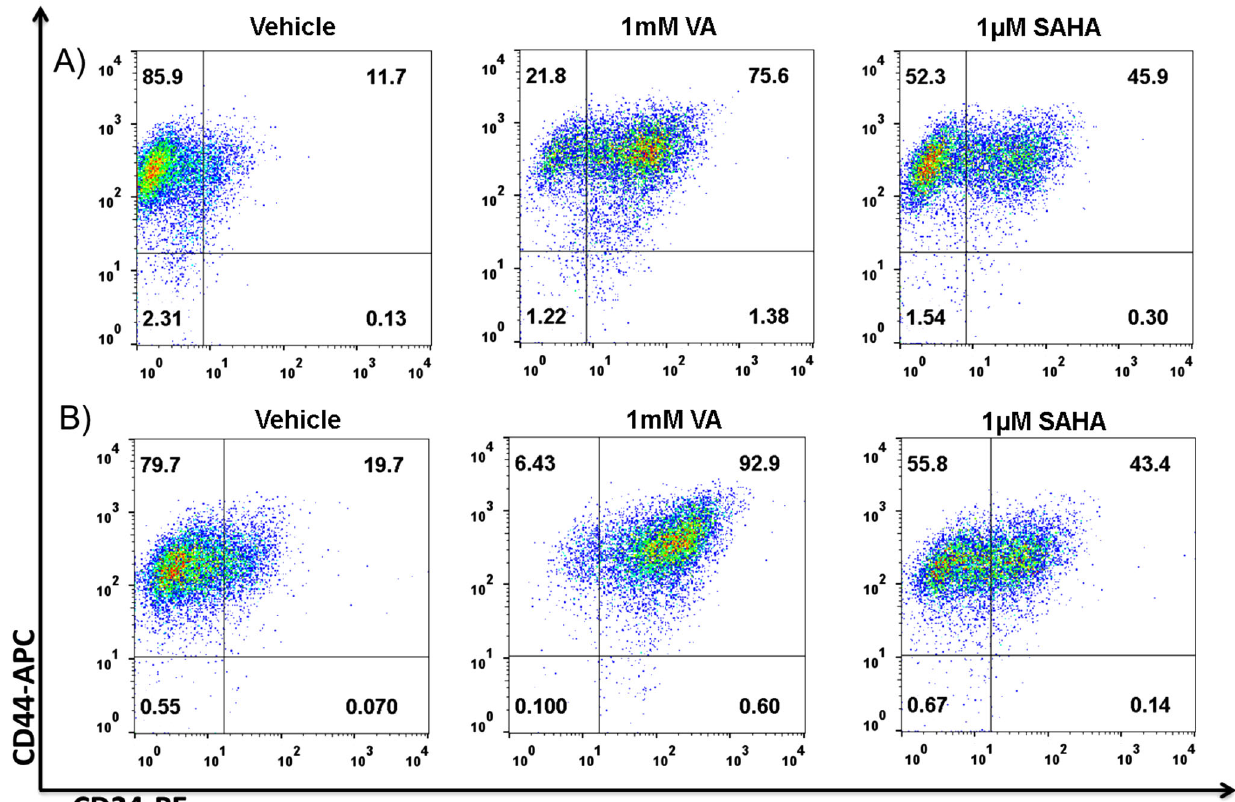
Fig. 4 HDAC inhibitors expand the CD44 + /CD24 + subpopulation. Flow cytometry analysis of expression of CD24 and CD44 in a ALDH − and b ALDH + SUM159 cells showing a shift from the CD44 + /CD24 − in the vehicle-treated to a CD44 + /CD24 + population in 1 mM VA or 1 µM SAHA treated cells. Representative fl ow cytometry data is shown. Gating was set to unstained control cells. 61 For analyzing the CD44/ CD24 subpopulation, cells were harvested with trypsin, centrifuged and re-suspended in phosphate buffered saline (PBS) (10 5 cells/ml). Cells were incubated with APC-conjugated CD44 and PE-conjugated CD24 antibodies (BD Biosciences, San Diego, CA, USA) for 30 min in ice at concentrations recommended by the manufacturer. Cells incubated in PBS and cells single-stained with APC-conjugated or PE-conjugated antibodies served as controls. Cell analysis for the expression of CD44 and CD24 was performed using a Beckman Coulter machine and the data fi les were analyzed using FlowJo software (Treestar, Ashland,